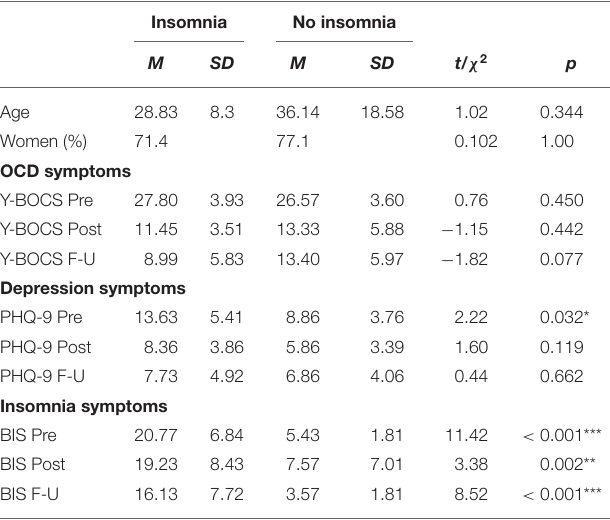
TABLE 3 | Sample comparison between patients with insomnia indication ( n = 35) and patients without insomnia indication ( n = 7). Insomnia No